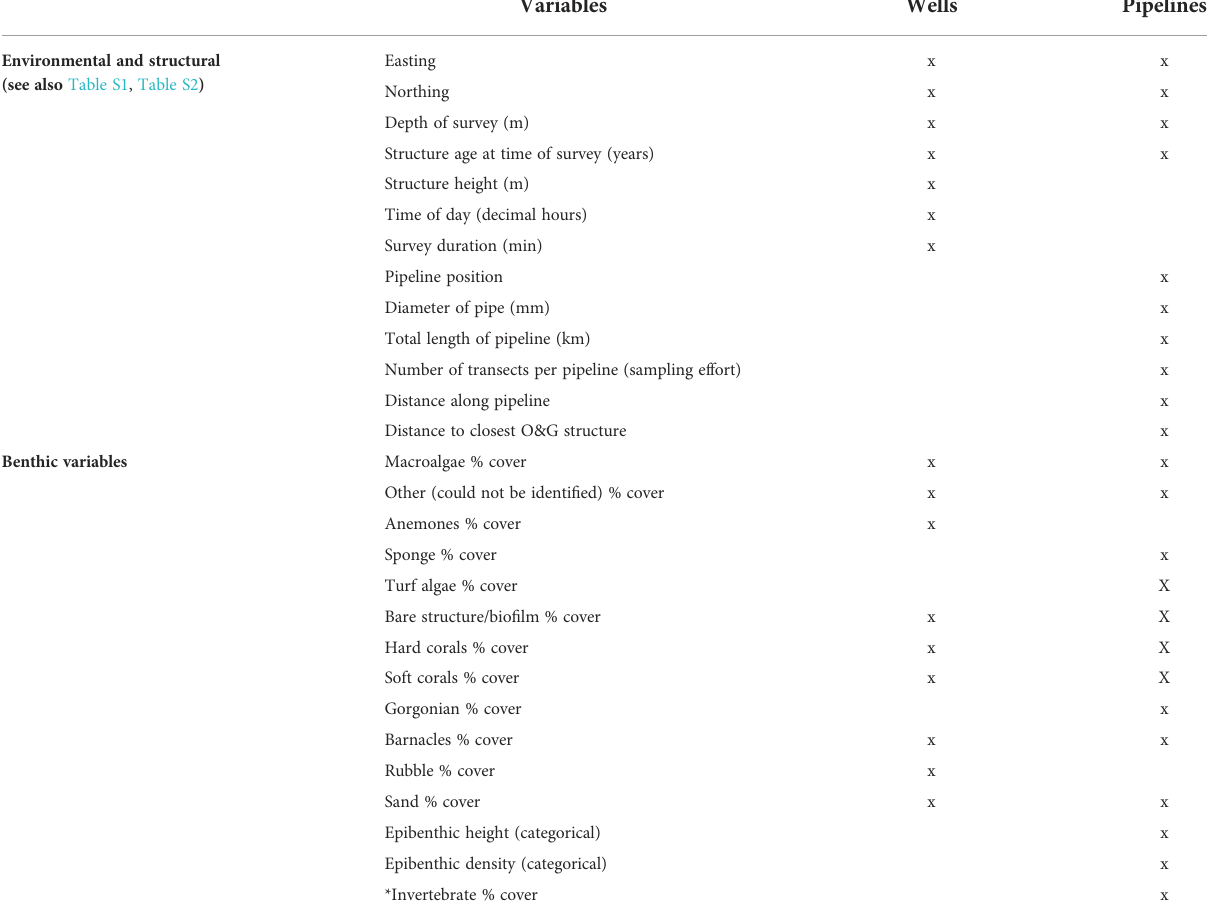
TABLE 1 List of variables recorded to examine relationships with fi sh communities observed on different infrastructure.